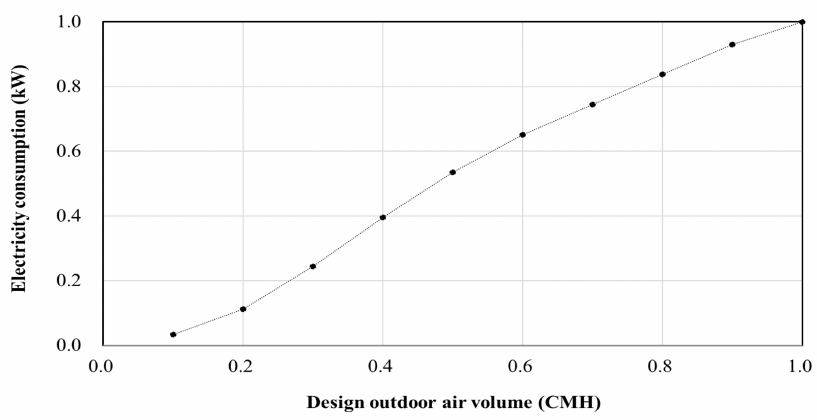
Figure 3. Fan model used for the calculation